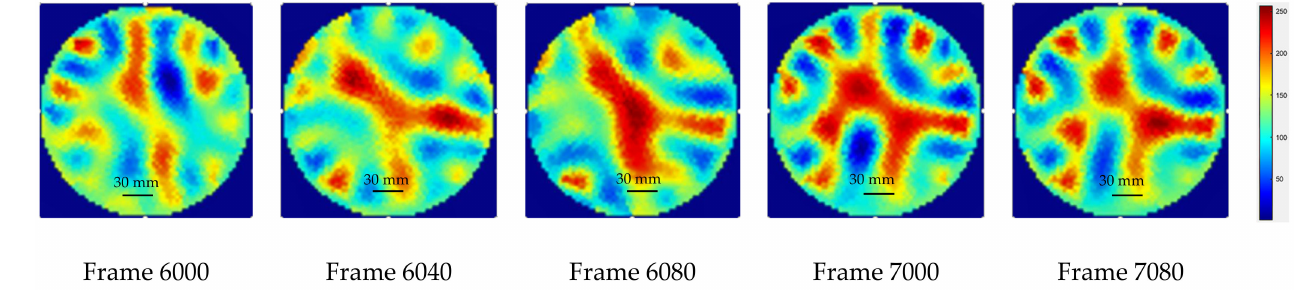
Figure 17. Observation of settling of CaCO 3 in the suspension at various stages of the experiment. Red regions indicate the CaCO 3 crystal regions.